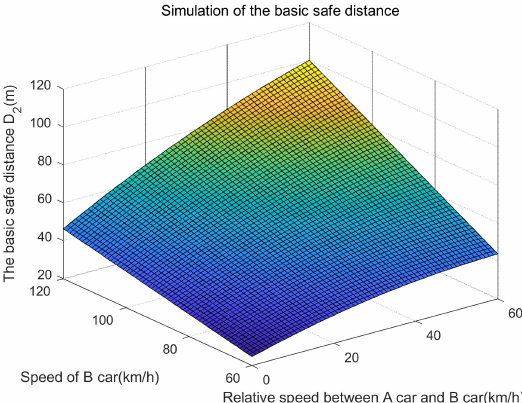
Figure 4. Changes in the basic safe distance D 2 with various V B and V r when i = 0 and d = 3.